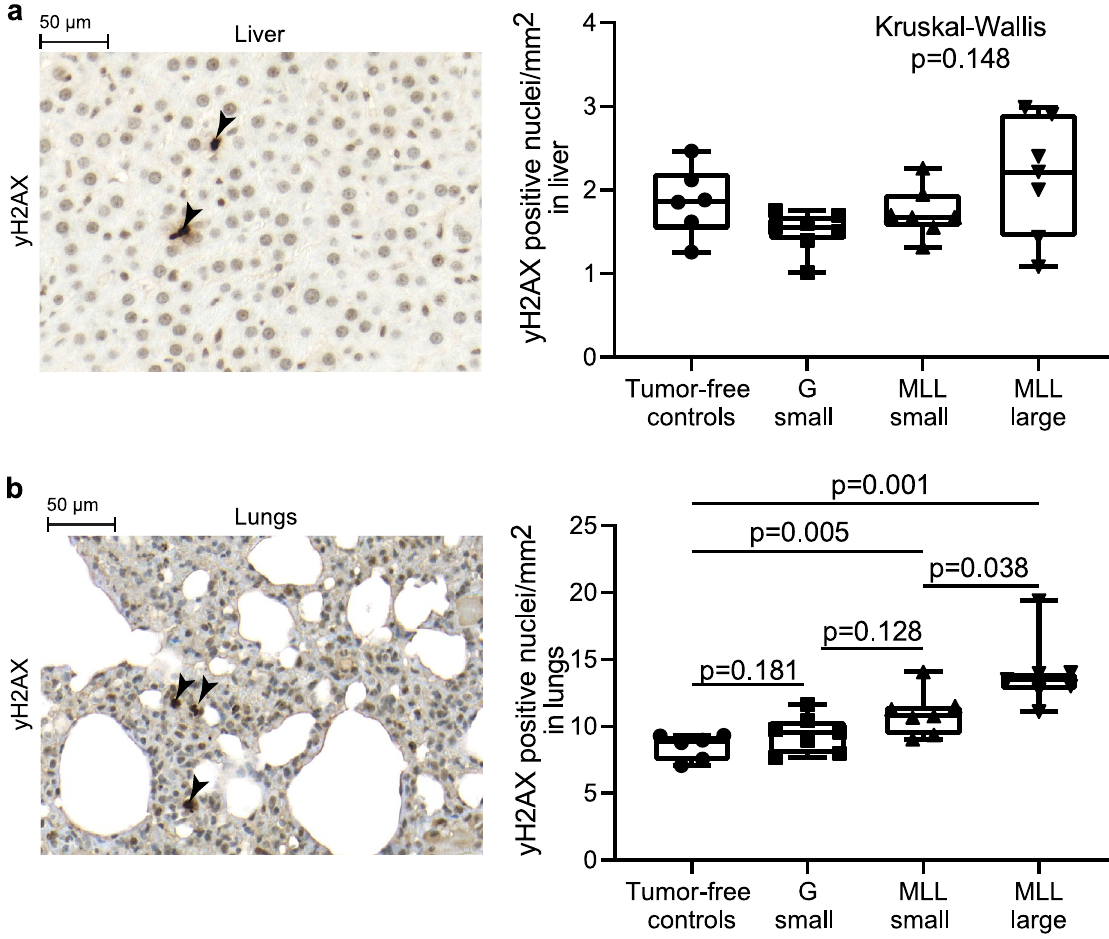
Figure 4. DNA-damage in liver and lungs in animals with intraprostatic tumors. Sections immune-stained for γH2AX (marker for DNA-damage) in liver ( a ) and lung tissue ( b ) in an animal with an intraprostatic MLL- tumor. Box plots showing the numbers of γH2AX + cells in liver ( a ) or lungs ( b ) of control rats, and in rats with intra-prostatic G or MLL-tumors. The number of γH2AX + cells was significantly increased in lungs by MLL- tumors compared to controls and in a tumor-size dependent way. The non-parametric Kruskal–Wallis H test was used for multiple comparison, if significant (p < 0.05), the non-parametric Mann–Whitney U test was used to compare two groups.